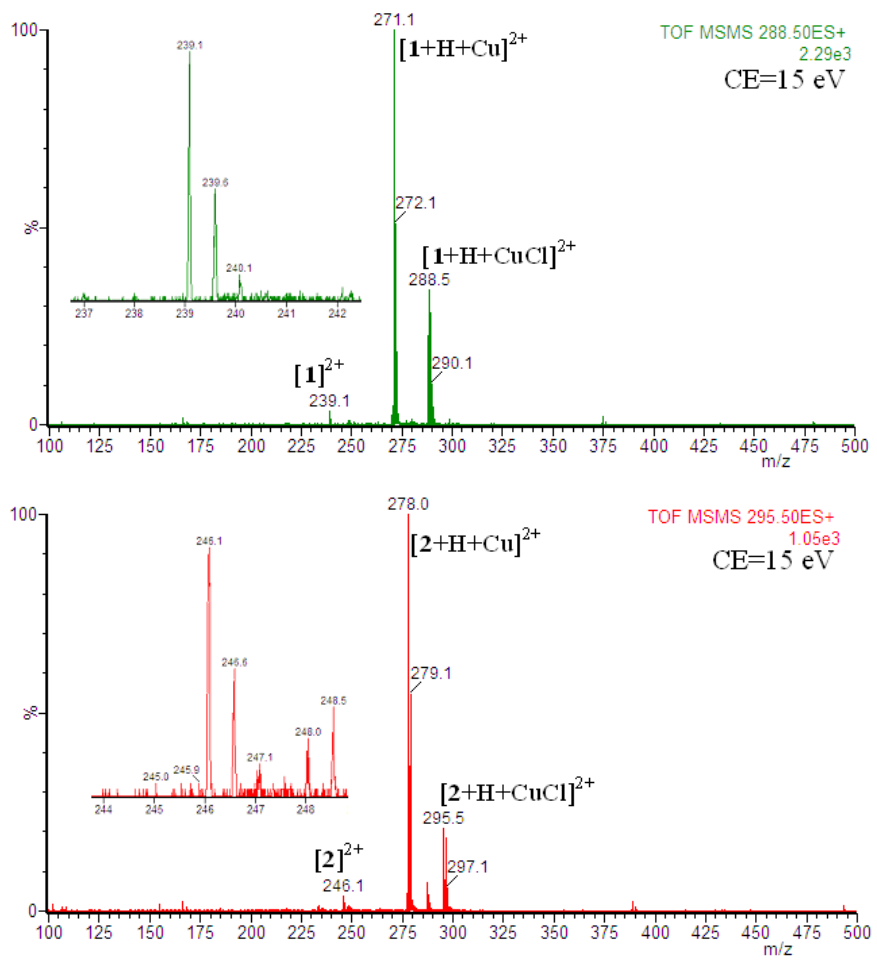
Figure 2: ESI-CID-MS/MS spectra of [ 1 +H+CuCl] 2+ and [ 2 +H+CuCl] 2+ ions.